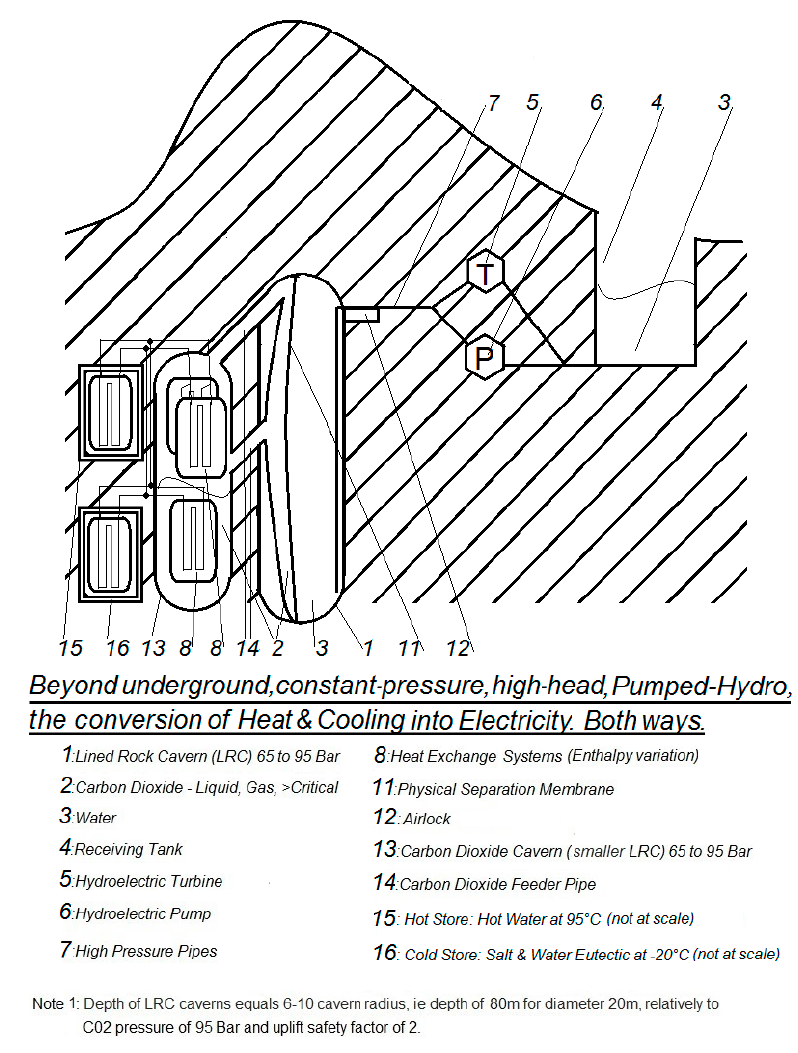
Figure 7. Main components of the hybrid UPHES-PTES for long-duration storage (here in stand-alone configuration and with a smaller pressurized cavern dedicated to CO 2 ). UPHES for storage of short and medium duration uses the same components, except for the absence of the two large thermal stores.